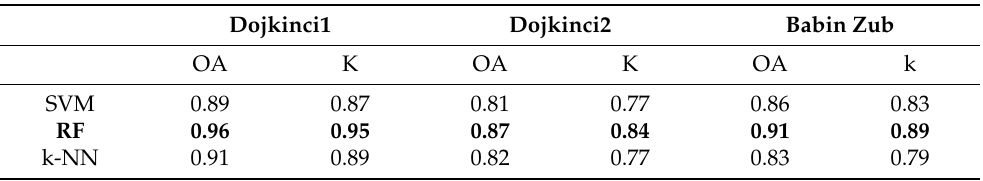
Table 4. Calculated overall accuracies (OA) and Kappa indices (k) for SVM, RF, and k-NN classifiers for all three study sites.